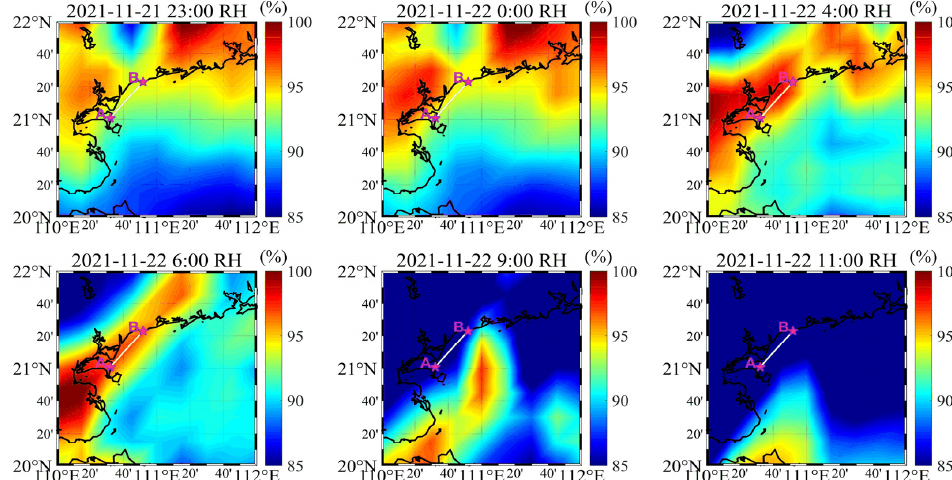
Figure 12. Spatial distribution of RH in the study area at the six typical times.